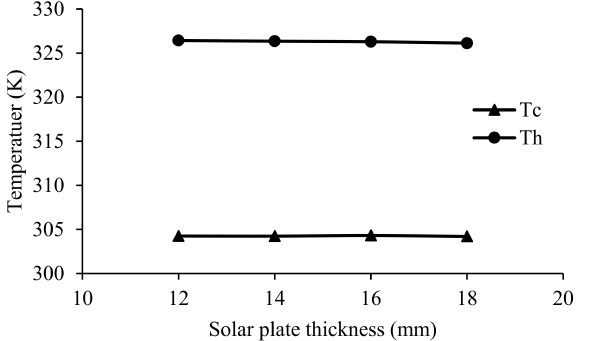
Figure 7. The effects of the solar plate thickness on the temperature of the module’s hot and cold surfaces.